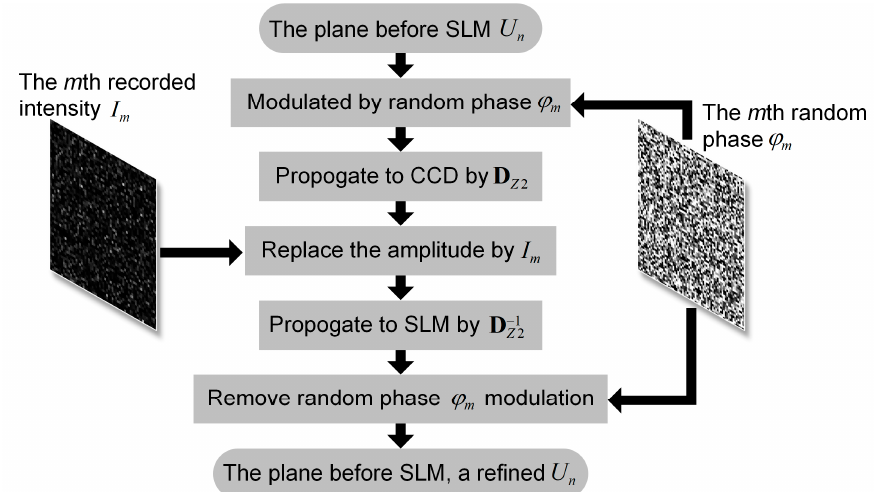
Figure 3. The flow chart of the refinement procedure of U n